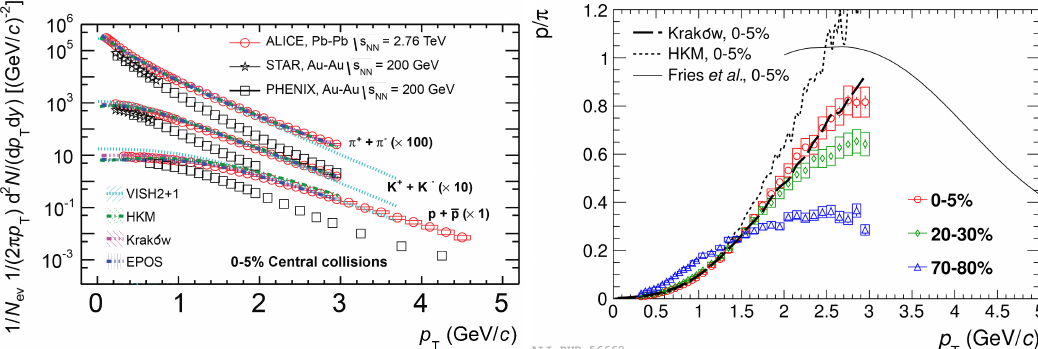
Figure 2. ( Left ) p T spectra of particles for summed charged states at 0–5% centrality, compared to hydrodynamical models and results from RHIC; and ( Right ) proton over pion ratio as a function of p T at different centralities. Both figures are taken from